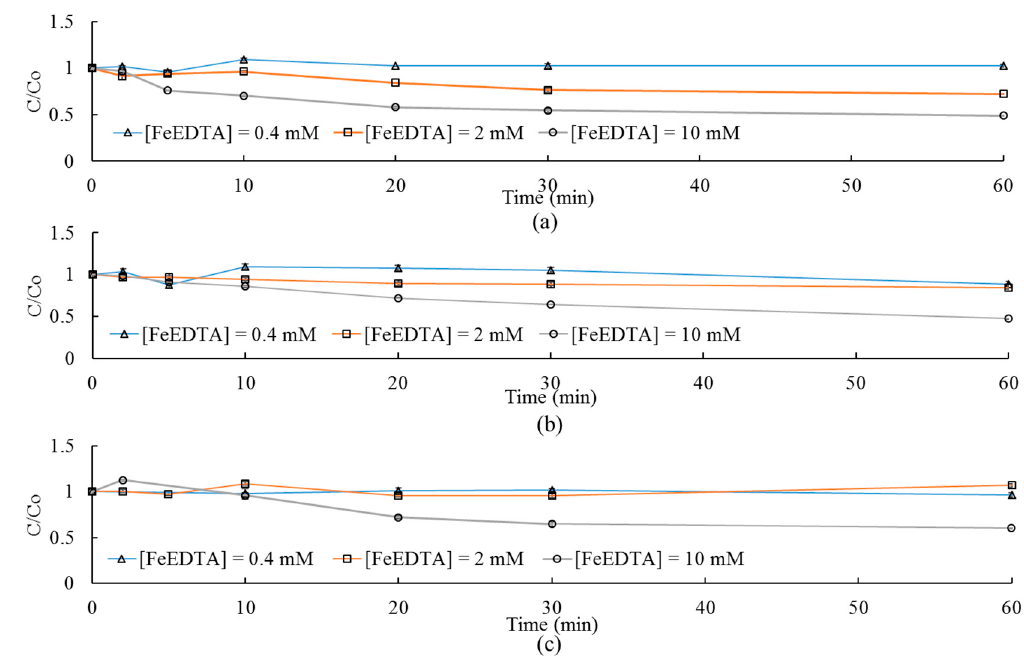
Figure 7. Sulfolane degradation in SWW with neutral Fenton; ( a ) no dilution, ( b ) 5 × dilution, and ( c ) 500 × dilution. The error bars represent the variation of duplicates.